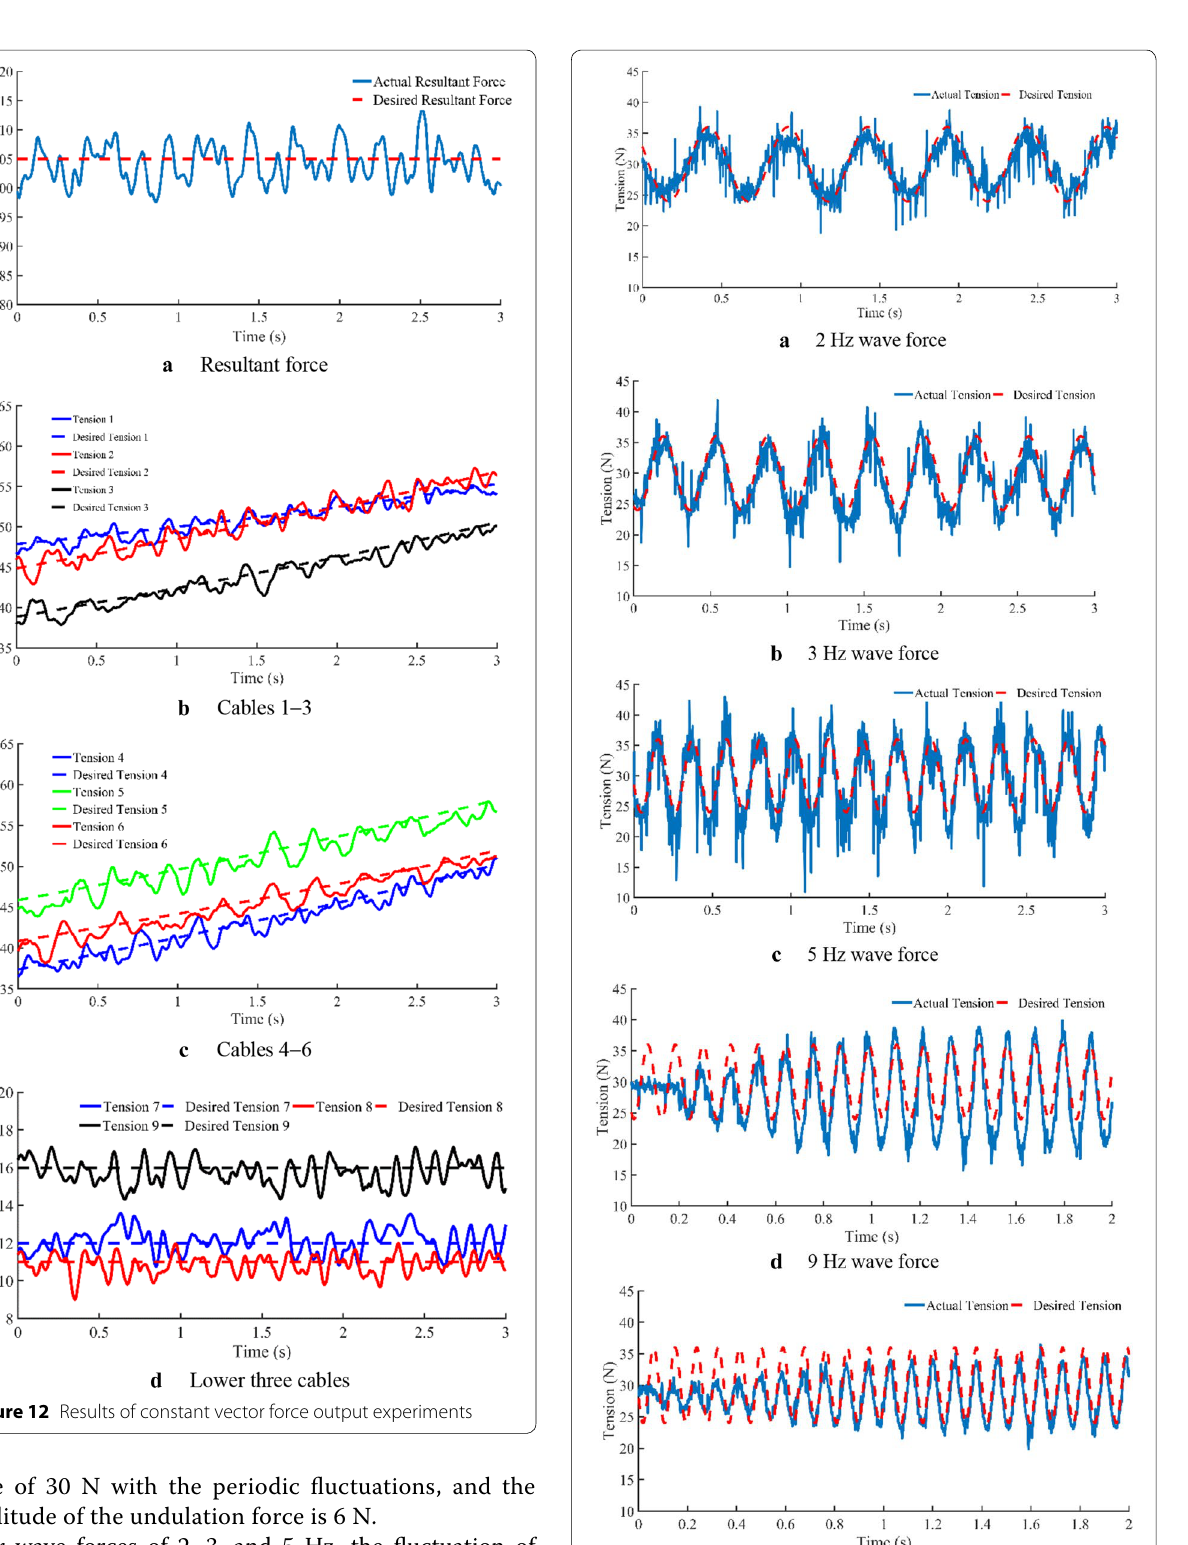
force of 30 N with the periodic fluctuations, and the amplitude of the undulation force is 6 N. For wave forces of 2, 3, and 5 Hz, the fluctuation of the actual output cable force is about 5.5, 6, and 7.5 N, respectively. In the case of the 5 Hz wave force, the actual